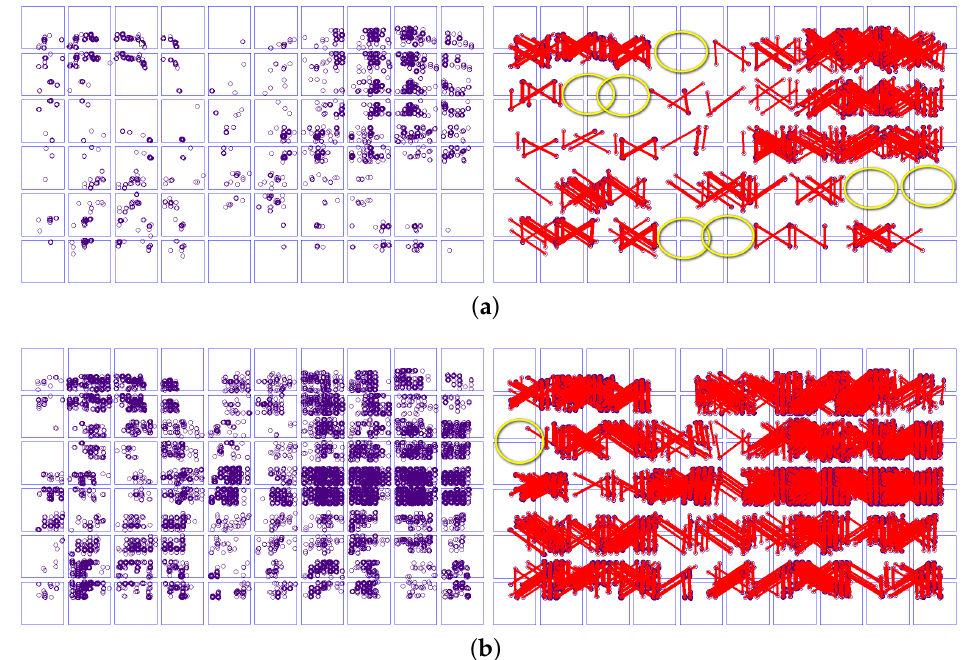
Figure 12. Show of lateral image tie points (purple circle).There are 0 or 1 tie point in the yello circle. ( a ) Block-SIFT (Left is tie points and right is tie lines (red line)); ( b ) LR-SuperGlue (Left is tie points and right is tie